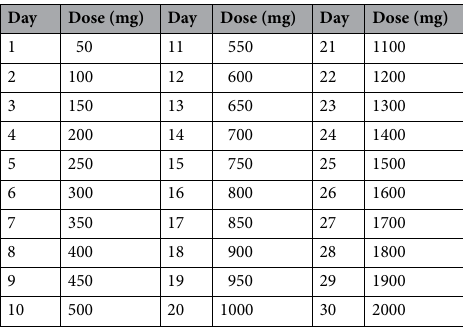
Table 1. Desensitization protocol with time dependent-mesalazine